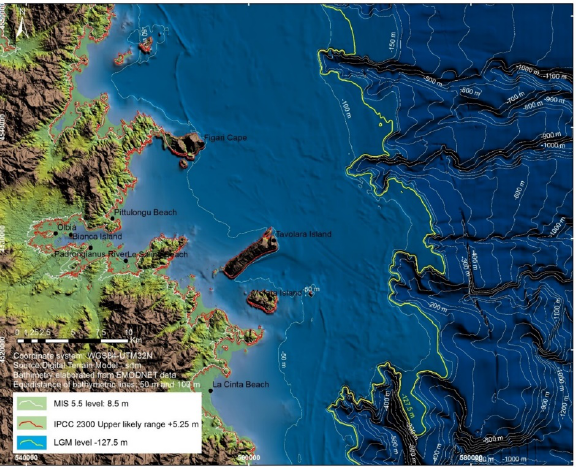
Figure 20. Olbia plane map showing the potential submersion area using IPCC AR5 RCP 8.5 for 2100 and 2300: the MIS 5.5 extension occurred 119 ka BP.